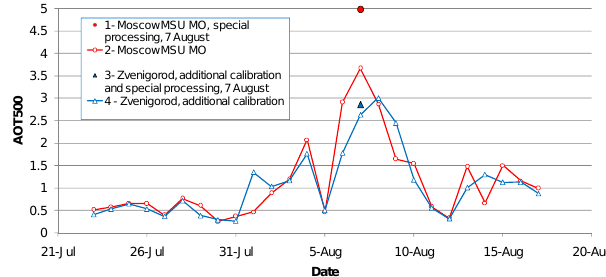
Fig. 4. Daily mean AOT500 time series in Moscow and Zvenig- Fig.4. Daily mean AOT500 time series in Moscow and Zvenigorod during the most orod during the most intensive fire event from 23 July to 17 Au- intensive fire event from 23.07 to 17.08.2010. 1 - Moscow MSU MO AOT500, special processing on August 7 (see the details in the gust 2010. (1) Moscow MSU MO AOT500, special processing Section 2); on 7 August (see the details in Sect. 2); (2) Moscow MSU MO 2 - Moscow MSU MO AOT500, AERONET level 2; 3 - Zvenigorod AOT500, special processing on 7 August and an application of AOT500, AERONET level 2; (3) Zvenigorod AOT500, special pro- additional calibration (see the details in the Section 2); cessing on 7 August and an application of additional calibration 4 - Zvenigorod AOT500, an application of additional calibration and cloud-screening (see the details in Sect. 2); (4) Zvenigorod AOT500, an application filter (Smirnov et al., 2000). of additional calibration and cloud-screening filter (Smirnov et al.,